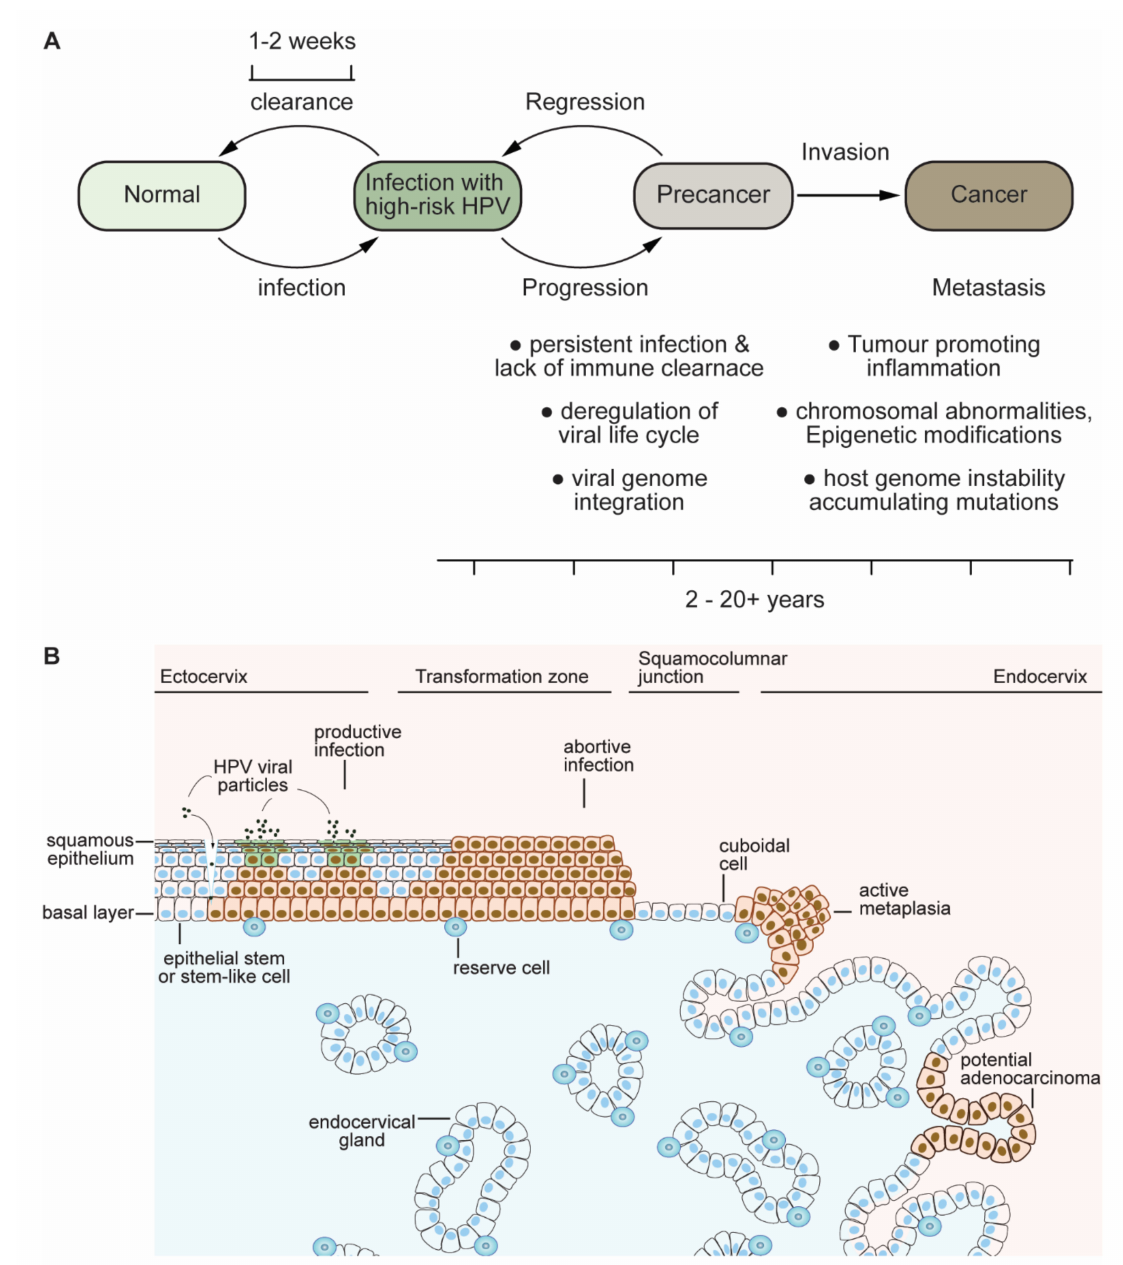
Figure 2. From infection to the development of cancer and malignancy, mediated by HPV (adapted and modified from References [22,23]. ( A ) Infection with HPV is normally cleared with 1 to 2 weeks; however, in certain individuals, persistent infection and a lack of immune clearance can lead to deregulation of the viral life cycle and viral genome integration, making them major risk factors for tumour development and progression towards cancer and malignancy. The progression towards invasive cancer and metastasis involves several changes, including chromosomal abnormalities, epigenetic modifications, genome instability and accumulating mutations and tumour-promoting inflammation, taking 2 to 20-plus years. ( B ) A cartoon representing infection by HPVs and progression to cancer. Infection with HPV is thought to occur via microtraumas in the epithelium, allowing access of the virus to the basal cell layer. HPV maintains its genome in the basal cells, and, as these cell divide, there is coordinated expression of early viral proteins, including E6 and E7, that allows the differentiation- determined cells to reinitiate the cell cycle. As these cells reach the upper squamous layers, with a concomitant expression of viral late gene products L1 and L2, new virions are released upon desquamation. Various regions of the cervix composed of stratified epithelium of the ectocervix, the transformation zone and the columnar epithelium of the cervix and endocervix are indicated in the cartoon, suggesting major sites of productive infections leading to the release of viral particles and abortive infection associated with deregulated HPV gene expression, potentially leading to squamous cell carcinoma and